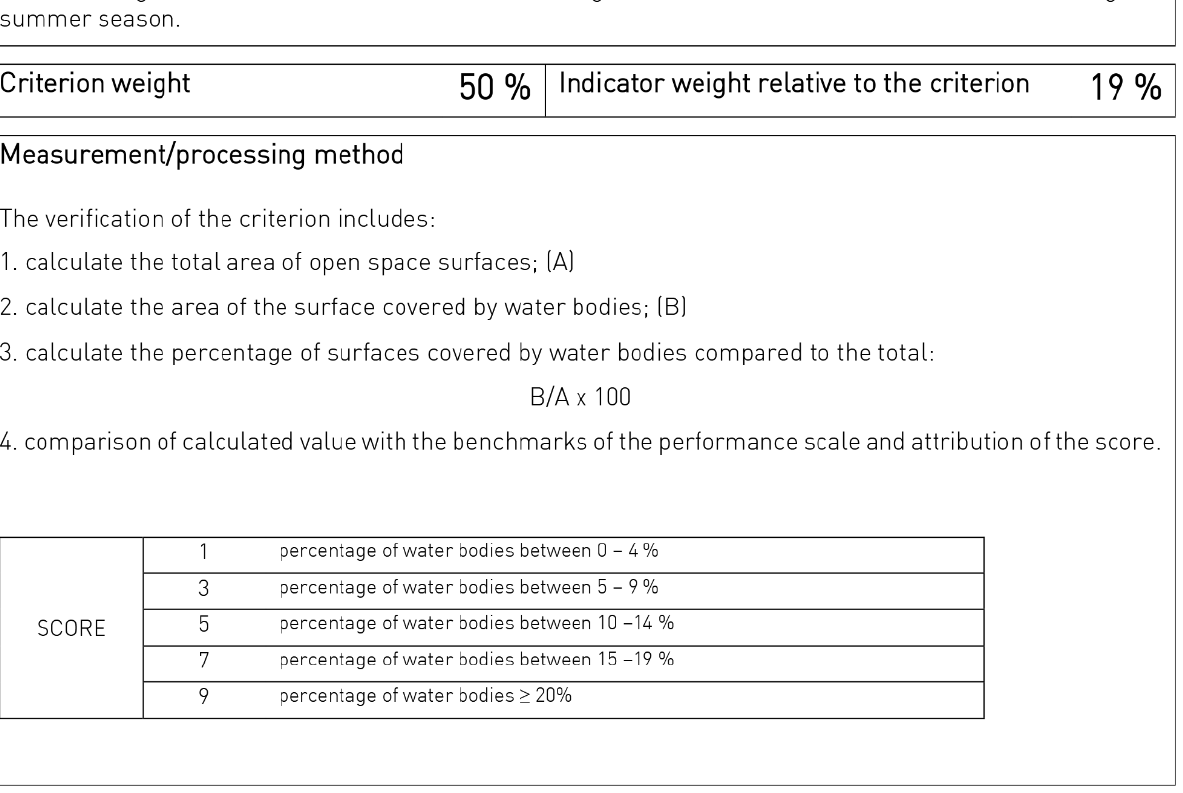
Figure A13. Descriptive sheet of the indicator of “Water bodies”.